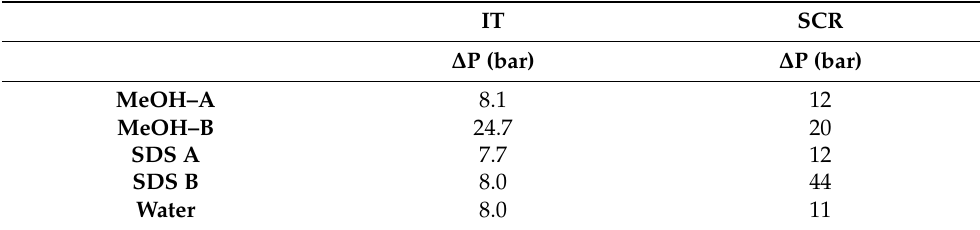
Table 4. Total pressure drop in the presence of MeOH, SDS, and water during fresh runs at T = 1 ◦ C and for P = 80